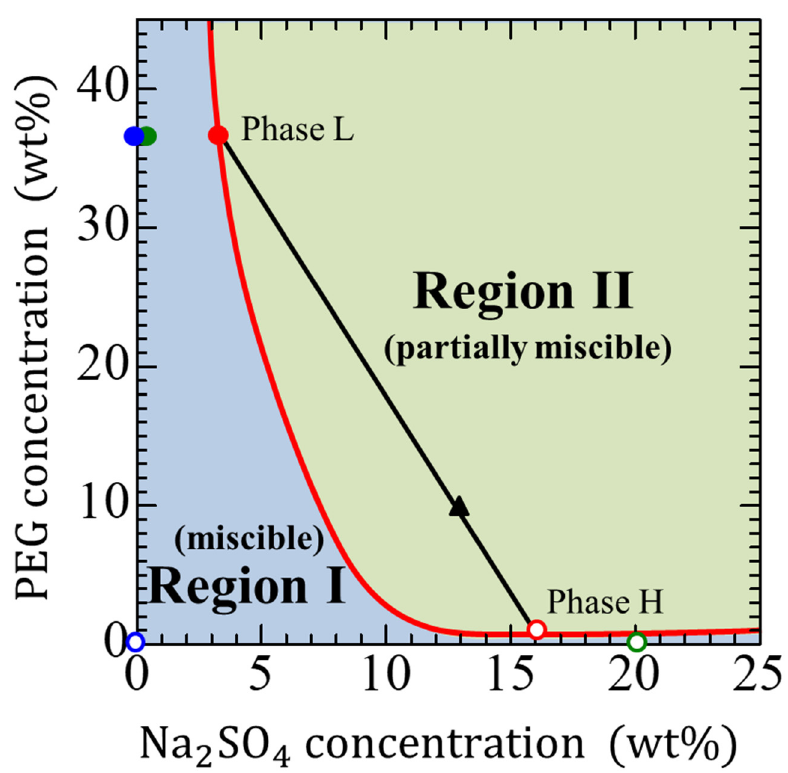
Figure 1. Phase diagram of the polyethylene glycol (PEG)–Na 2 SO 4 –water system [15]. The different color symbols show the three systems having different three thermodynamic states: the red circles for the immiscible system, the blue circles for the fully miscible system, and the green circles for the partially miscible system. The closed circles mean more viscous solutions and open ones mean less viscous solutions. The black line is the tie-line, whose end points determine the equilibrium phase compositions. The red curve represents the binodal curve, indicating equilibrium compositions of the two immiscible phases after separation. Table 1. Physicochemical properties of the considered system.